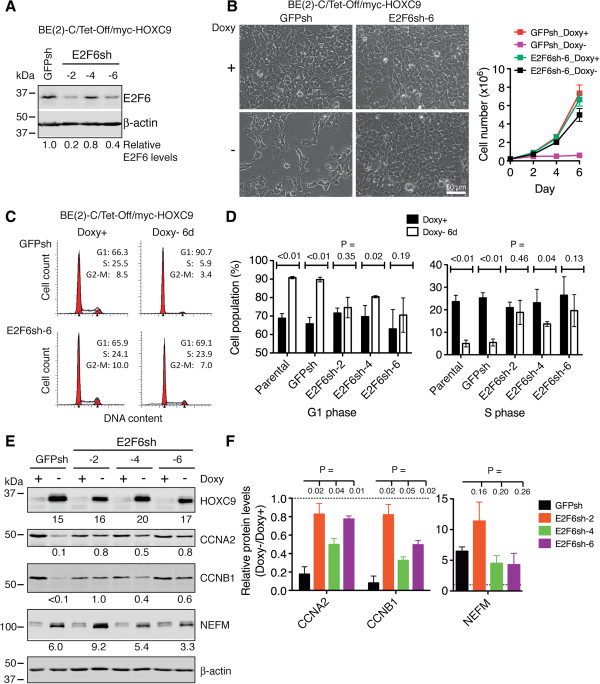
E2F6 is essential for HOXC9 induction of G1 arrest and repression of cell cycle genes. (A) Immunoblot analysis of E2F6 levels in BE(2)-C/Tet-Off/myc-HOXC9 cells infected with lentiviruses expressing shRNA against GFP or various coding regions of E2F6. E2F6 levels were quantified against β-actin. (B-D) Phase contrast imaging and growth assay (B) and cell cycle analysis (C, D) showing E2F6 knockdown abrogated HOXC9-induced growth arrest. Error bars, SD (n = 4). (E-F) Immunoblot analysis (E) and quantification (F) showing that E2F6 knockdown abrogated HOXC9 repression of cyclins, but not HOXC9 induction of NEFM. HOXC9, CCNA2, CCNB1 and NEFM levels were quantified against β-actin with the protein levels in GFPsh-expressing cells cultured in the presence of doxycycline (Doxy+) were defined as 1.0 (dashed lines). Error bars, SD (n = 3). Data in (D) and (F) were analyzed with unpaired, two-tailed Student’s t-test and p values are indicated.